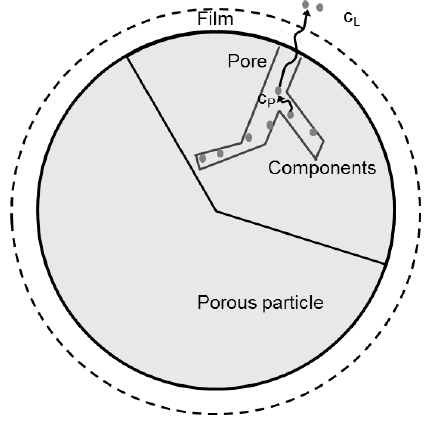
Figure 5. Principle of the pore diffusion model.